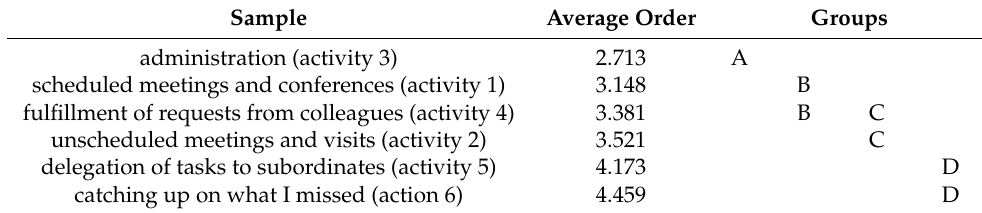
Table 7. Nemenyi’s method for the most performed activities.